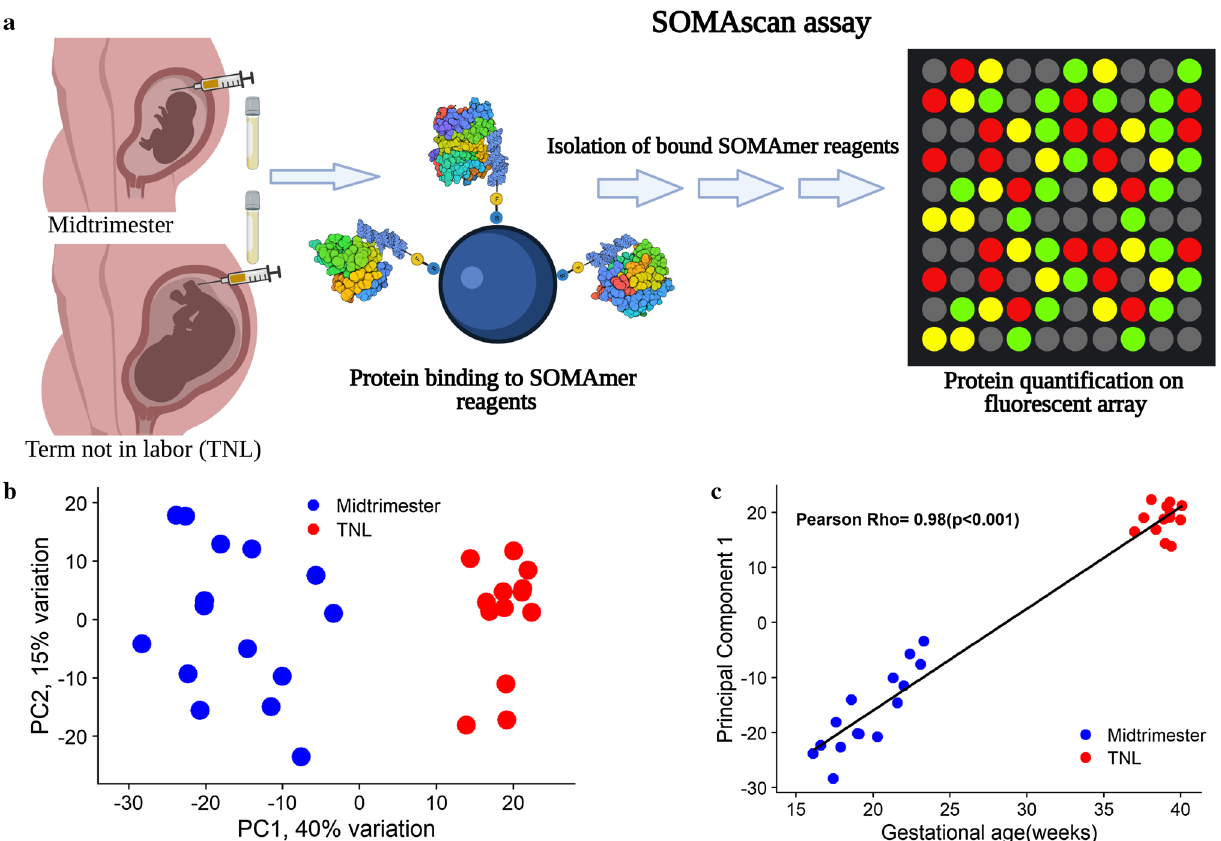
Figure 1. Gestational age-dependent changes in the amniotic fluid proteome. ( a ) The abundance of 1310 proteins was determined by the SOMAmer (Slow Off-rate Modified Aptamers) platform in amniotic fluid samples collected from pregnant women during midtrimester (16–24 weeks, n = 16) and from pregnant women at term without labor (37–42 weeks, n = 14). The figure was created with biorender.com based on the description of SOMAscan assay 101 . ( b ) Principal component analysis showing all samples depicted as their first and second principal components derived from the amniotic fluid proteomic data. The proportion of variance explained by each principal component is shown along the axis. The R package, PCAtools , was used to calculate and plot the principal components 114 . ( c ) Scatter plot (created in R 115 ) shows the linear correlation between gestational age and the first principal component along with the Pearson correlation